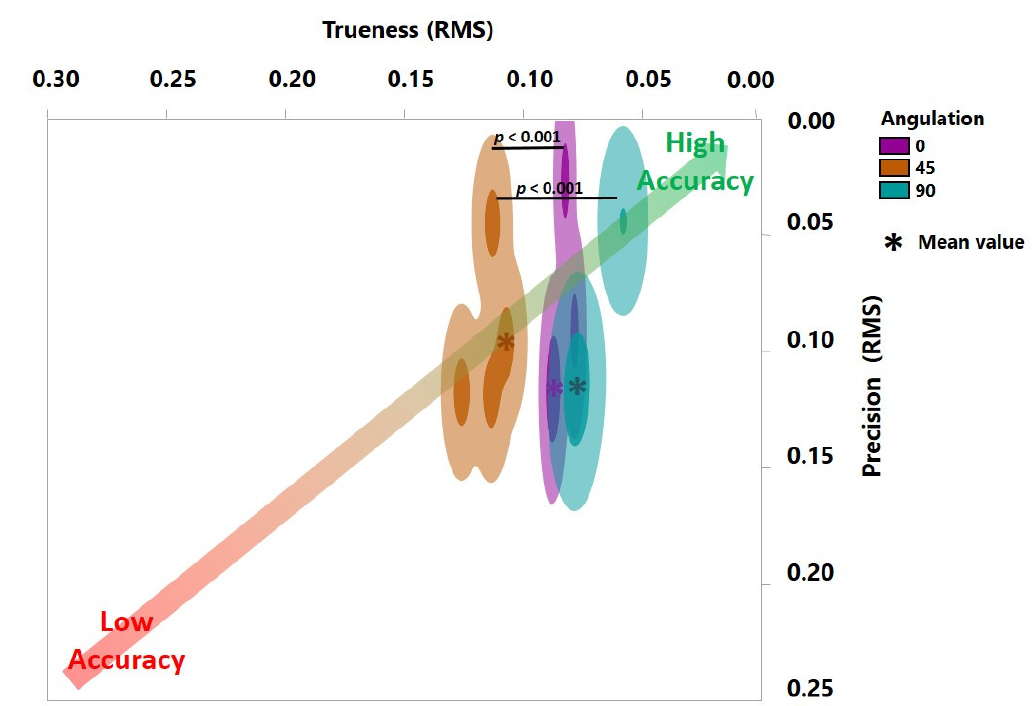
Figure 4. Accuracy of SLA-printed denture bases with three different build angles. Trueness is depicted horizontally and precision vertically. The p -value here with regard to trueness was calculated using Tukey’s analysis. No statistically significant difference was detected for precision.